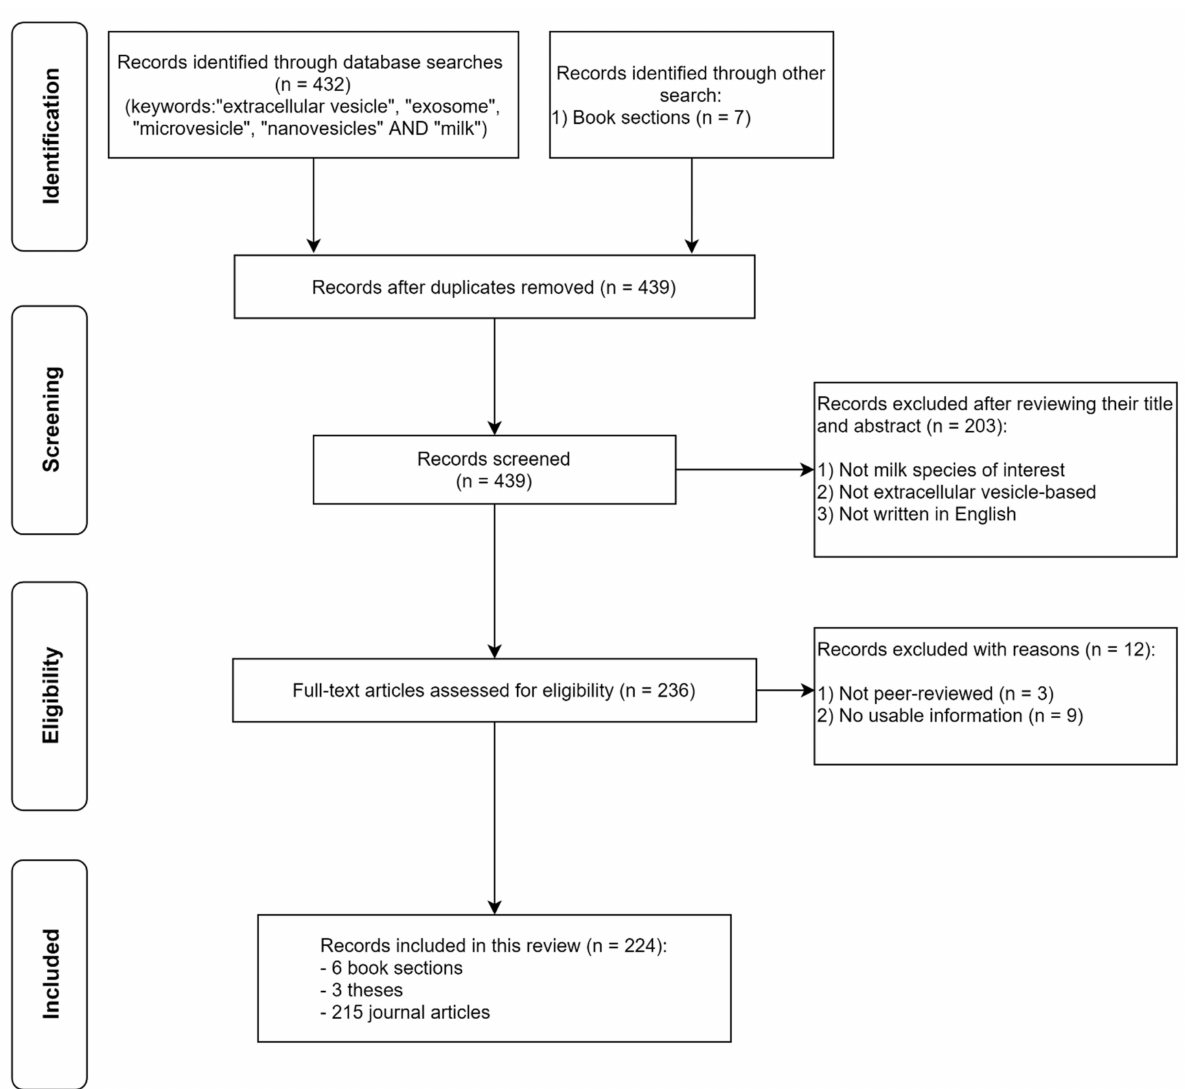
Figure 1. Schematic diagram for selection of included